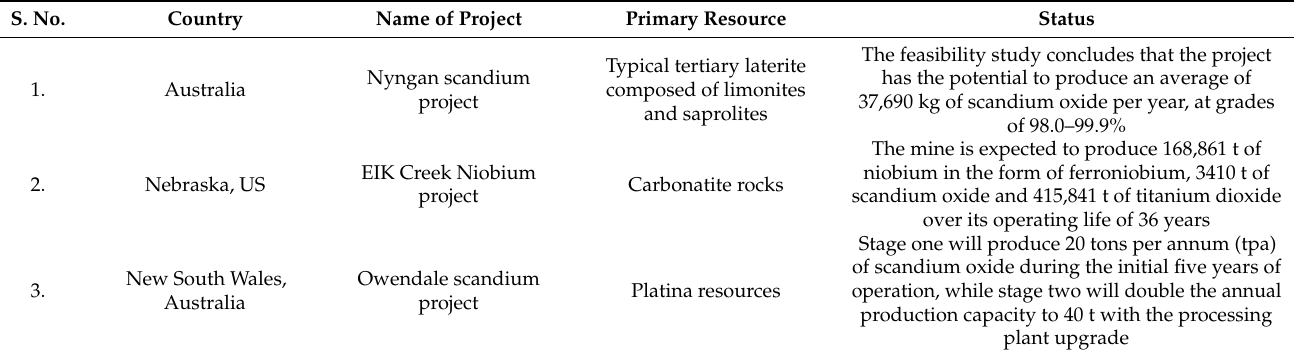
Table 8. Status of projects on scandium